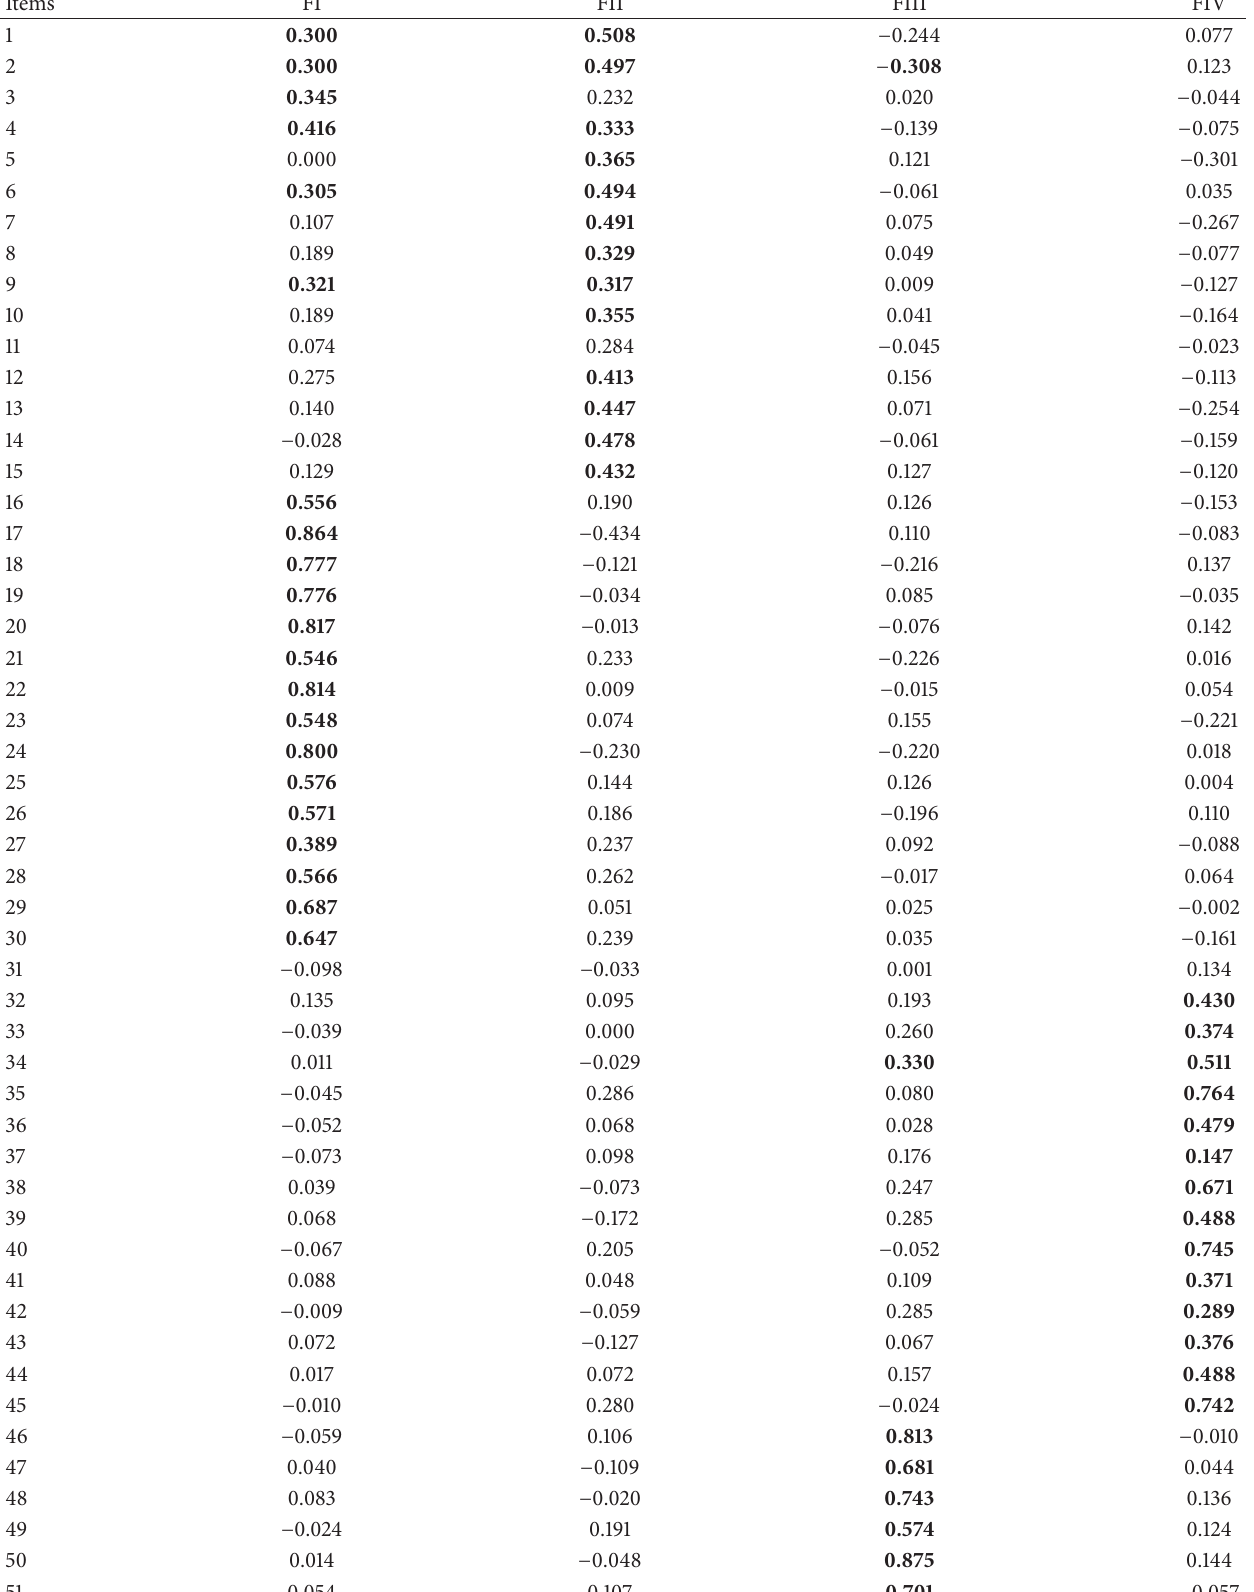
Table 3: Estimated factorial loadings for the four factor model through exploratory structural equation